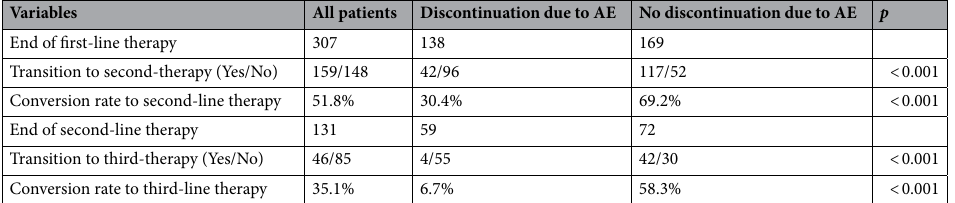
Table 3. Relationship between discontinuation due to AE and transition to next systemic therapy. AE adverse event.